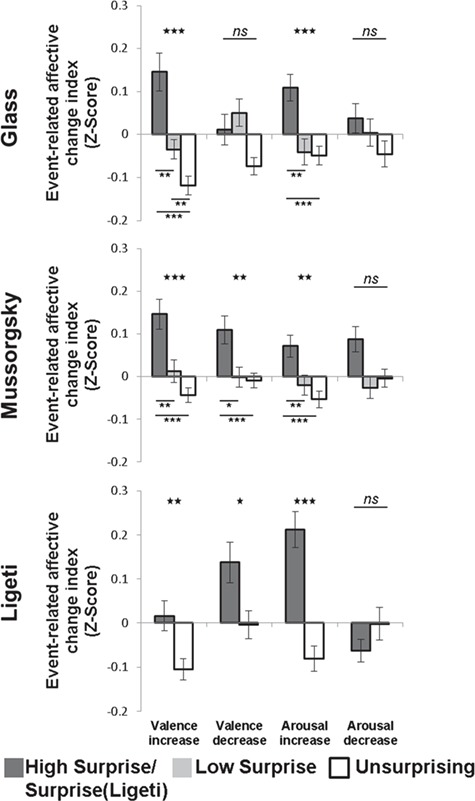
Transient changes in subjective valence and arousal reports are modulated as a function of surprise level. Relative to US events, surprising musical events associated with an increased arousal and valence across all musical pieces (Glass, top; Mussorgsky, center; Ligeti, bottom). In Mussorgsky and Ligeti surprises also related to greater valence decrease. Level of surprise is denoted by grayscale (highest is equal to dark). Stars above the graph bars denote significant main effects in Glass and Mussorgsky and significant pairwise comparisons in Ligeti; asterisks below the graph bars indicate significance of pairwise comparisons in Glass and Mussorgsky; significance of results is indicated: *P <0.05; **P < 0.01; ***P ≤ 0.001; qFDR < 0.05. Error bars represent 1 deviation from the mean (SEM).